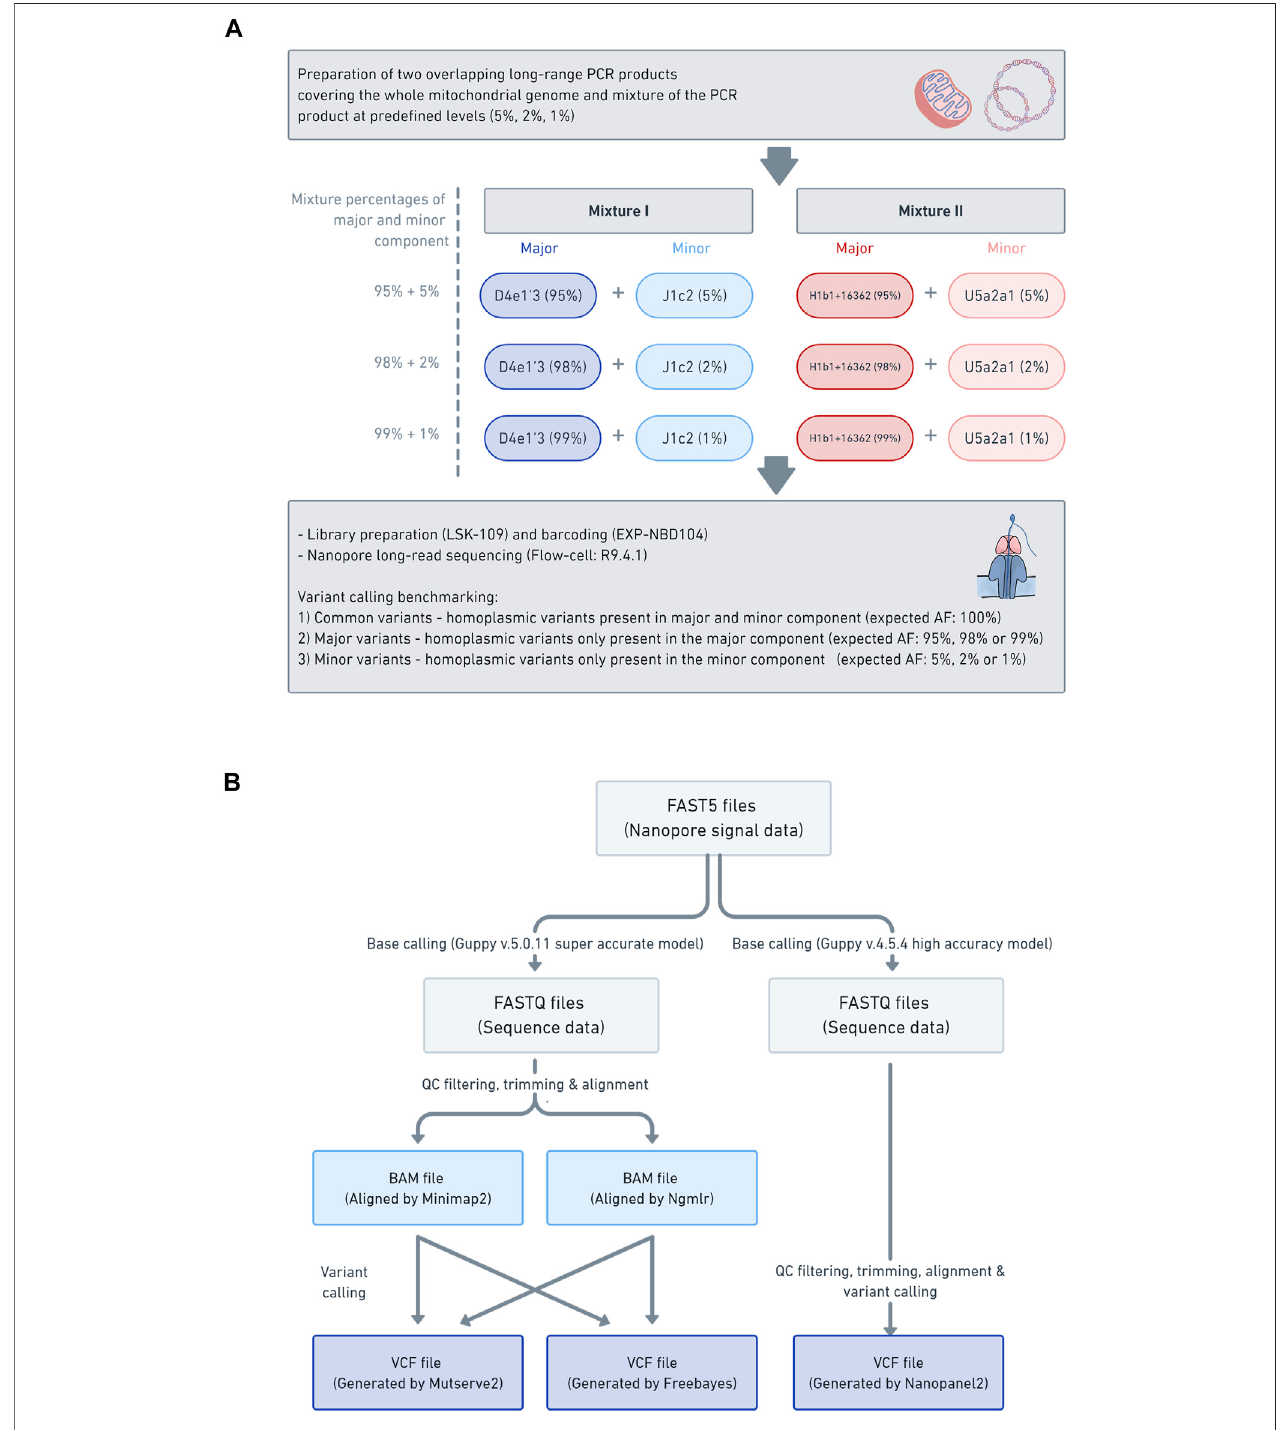
FIGURE 1 | Laboratory work fl ow data analysis pipeline (A) The schema illustrates the laboratory work fl ow for the preparation of the mitochondrial DNA (mtDNA) mixture models and subsequent nanopore sequencing (B) Work fl ow of how the mtDNA nanopore data was processed and which aligners (i.e., Minimap2 and Ngmlr) and variant callers (i.e., Mutserve2, Freebayes, and Nanopanel2) were used.